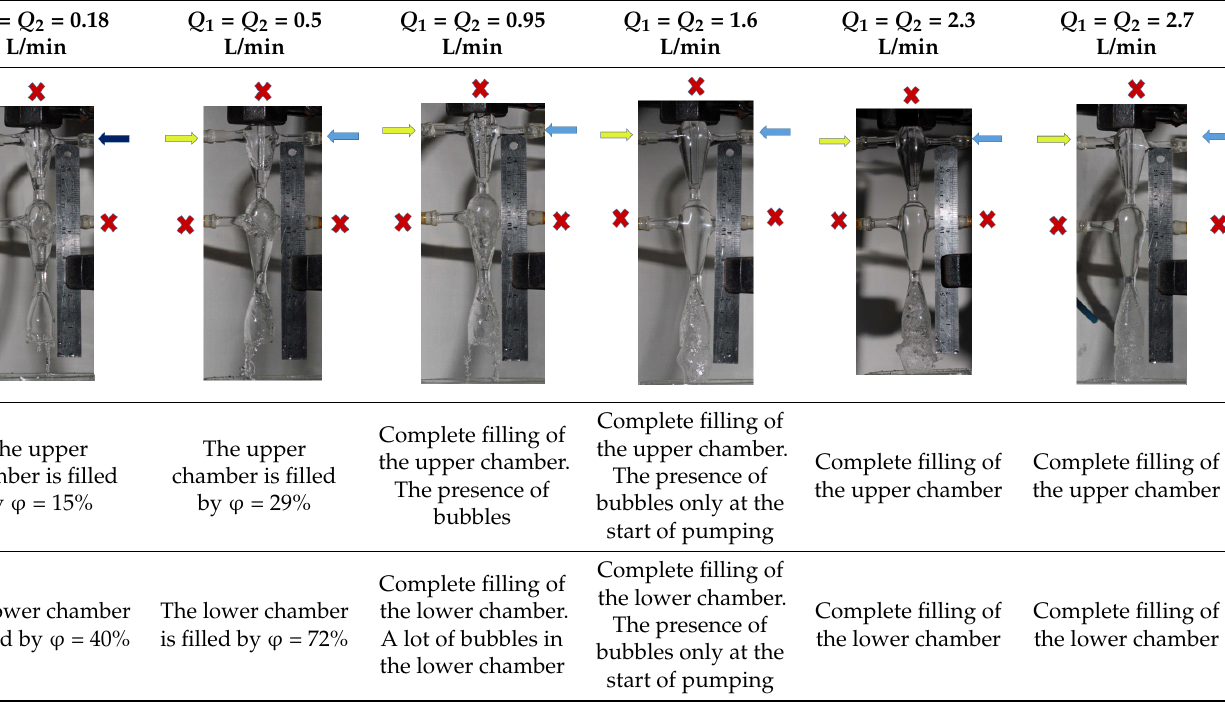
Table 2. Photographs of flow in the two-step microreactor with swirled flows and estimated volume of the micromixing zone V μ m for various flow rates Q 1 and Q 2 .